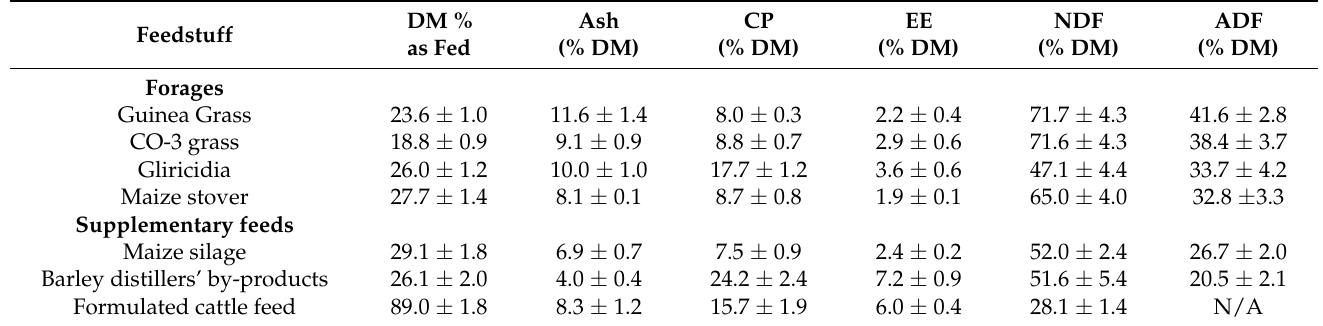
Table 2. Dry matter (DM; % as fed), ash, crude protein (CP; % DM), ether extract (EE; % DM), neutral detergent fibre (NDF; % DM), and acid detergent fibre (ADF; % DM) composition (mean ± SD) of feed sources available at the medium-scale dairy farms in the Kurunegala district, Sri Lanka.